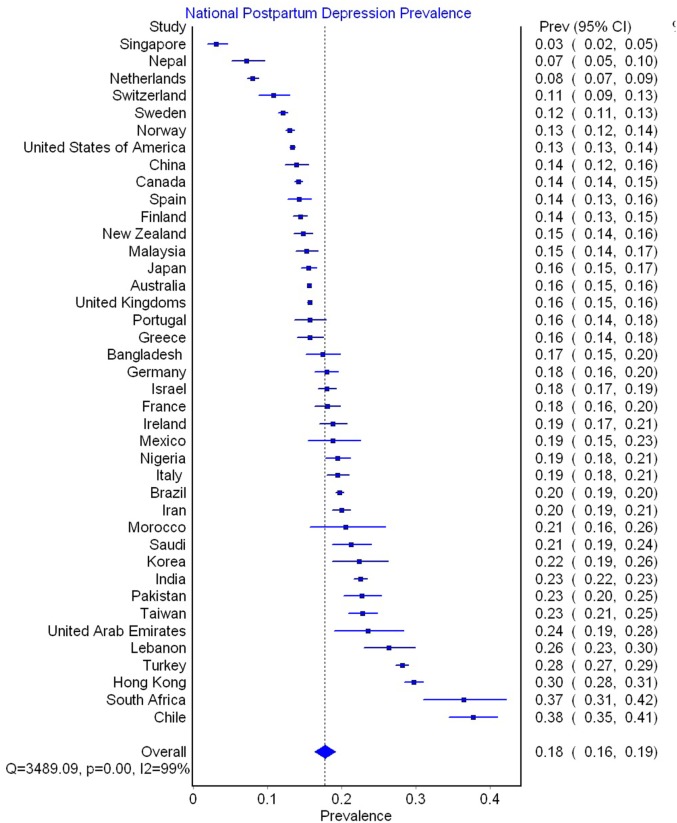
Meta-analytically derived postpartum depression prevalence in 40 Countries.